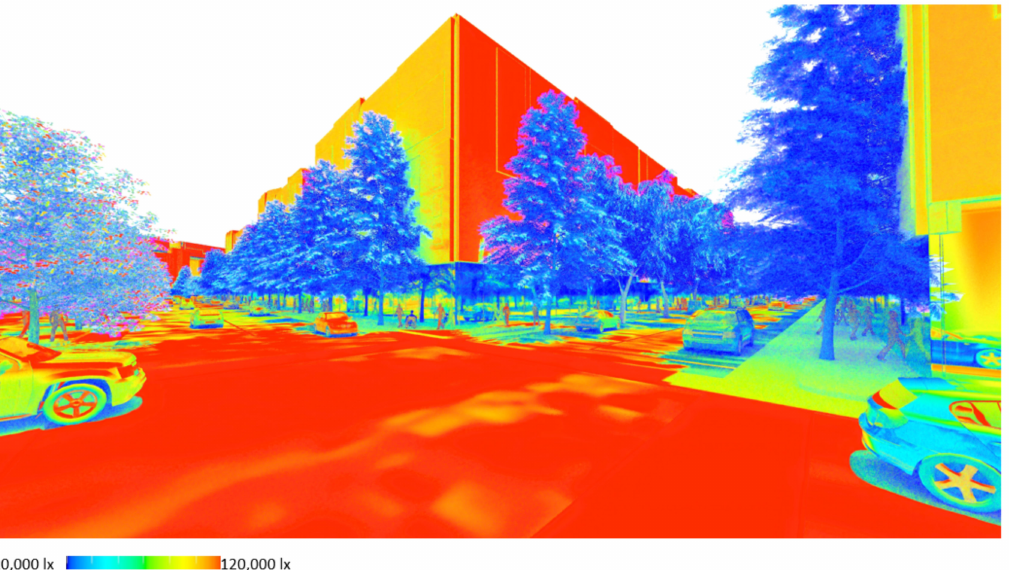
Figure 22. Rapid lux level lighting calculation for quick visual shading analysis at the streetscape scale. Image by authors using multi-criteria street tree design decision support modelling approach in Autodesk™ 3ds